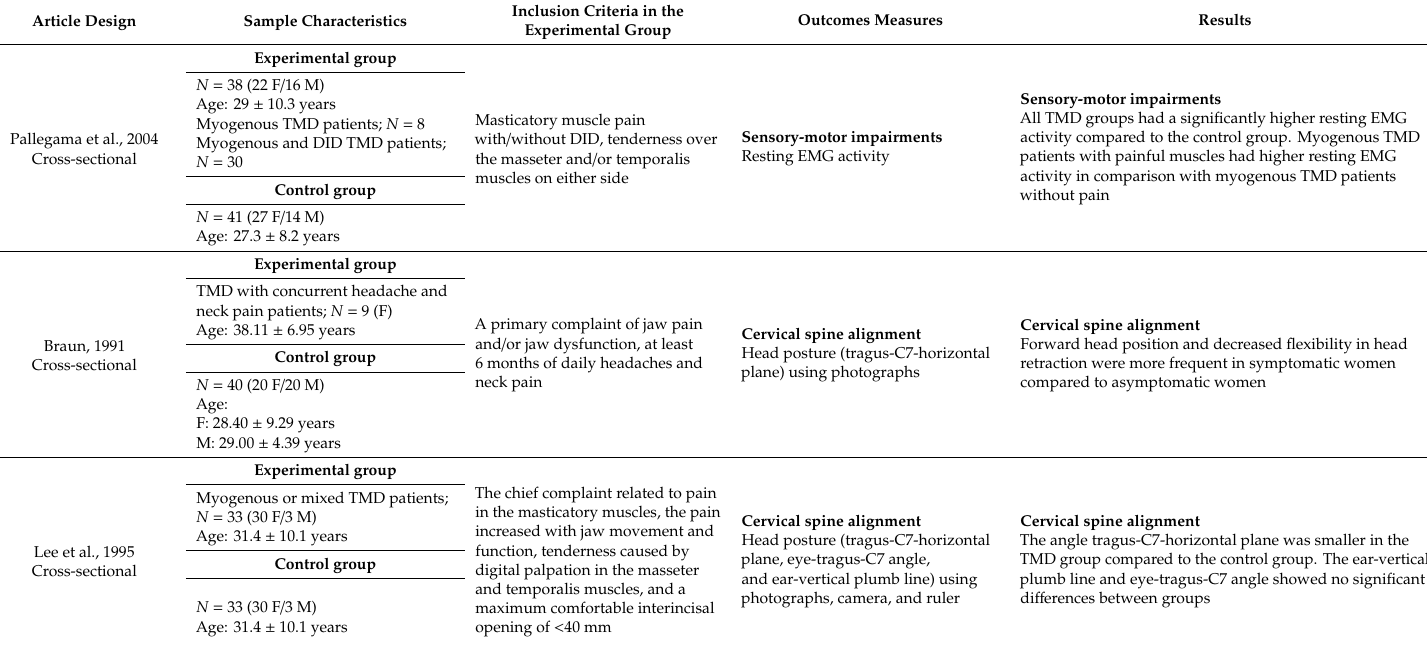
Cervical spine alignment Head posture (tragus-C7-horizontal plane, eye-tragus-C7 angle, and ear-vertical plumb line)